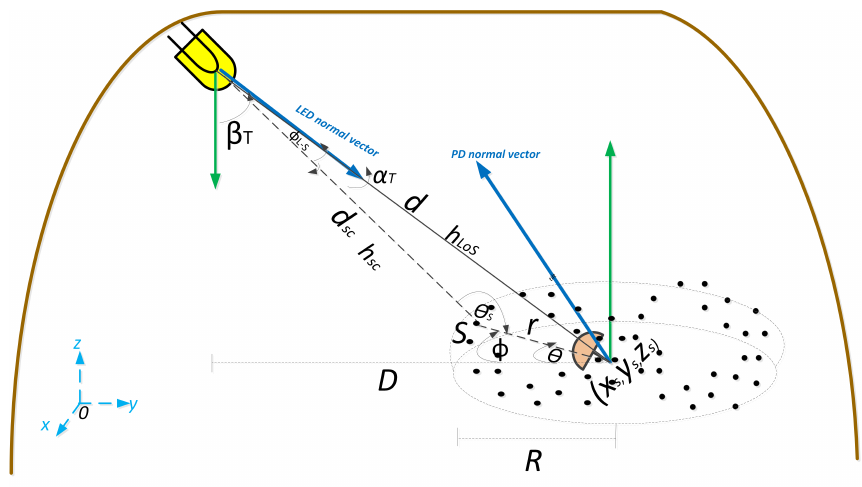
Figure 2. Proposed hemispherical scatterers spatial distribution around the PD for the downlink Cartesian/spherical coordinates relating the LED, an arbitrary dust particle, and the